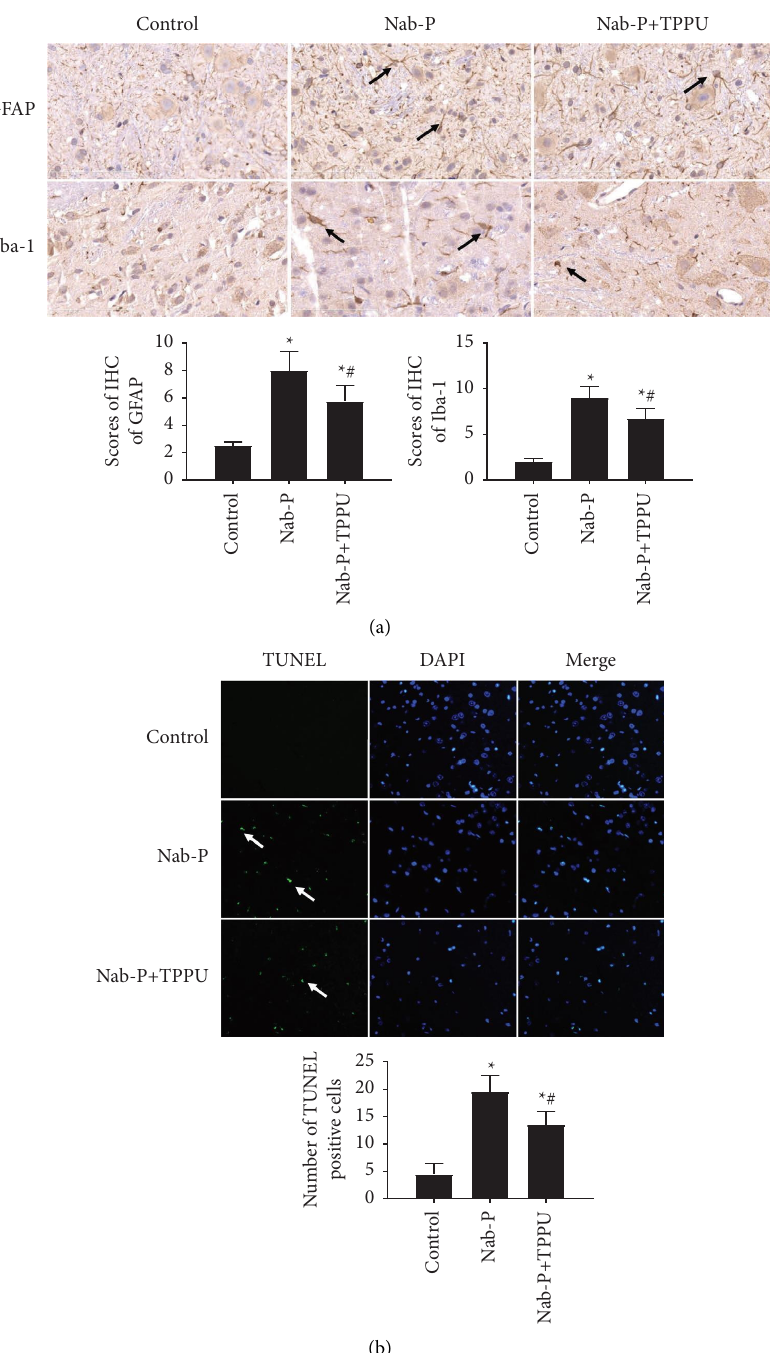
Figure 3: Inhibition of sEH signifcantly attenuates glial response and apoptosis after nab-paclitaxel treatment. (a) Immunohistochemistry was used to test the expression of GFAP and Iba-1 in the spinal cord of rats. Scale bars � 100 μ m. Black arrows indicate the GFAP and Iba-1 positive cells, respectively. (b) TUNEL assay was used to detect apoptotic cells. Stained green was considered as TUNEL-positive cells, and DAPI was used to stain the nuclei (blue) ( × 40 magnifcation). White arrows indicate the apoptotic cells. n � 6; ∗ P < 0 . 05 compared with the control group, # P < 0 . 05 compared to the nab-P